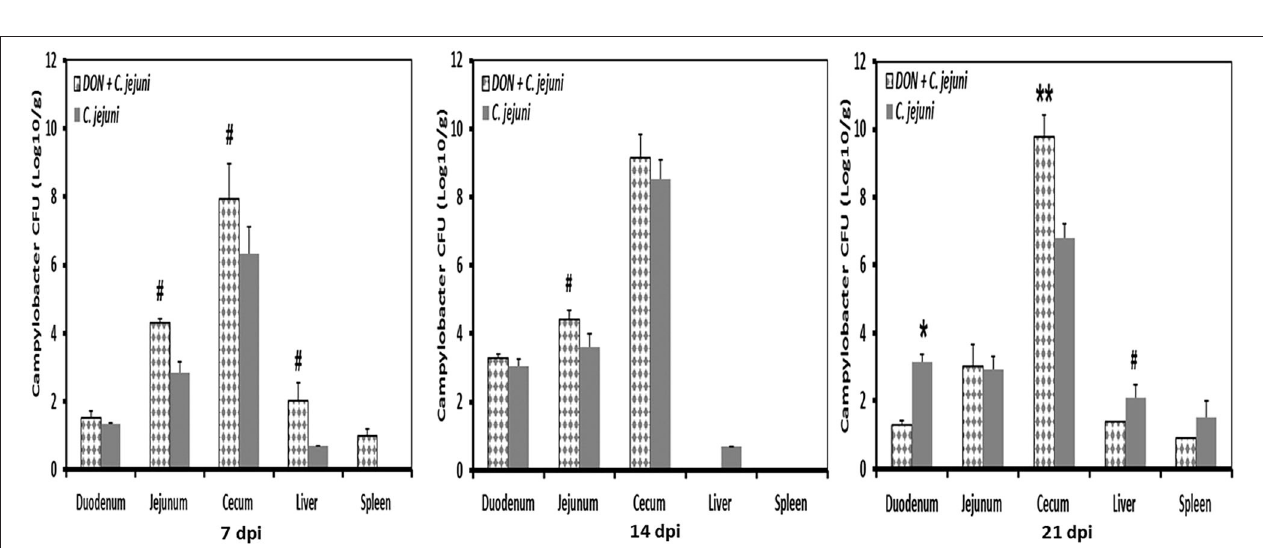
FIGURE 5 | C. jejuni counts at different time points post infection from duodenum, jejunum, cecum, liver, and spleen of infected birds fed with either control or DON contaminated diet. Results are presented as mean values and SEM ( n = 5). Numbers of bacteria are expressed in logarithmic form of colony forming units (log CFU/g). Asterisks mark differences with # P ≤ 0.1, or * P ≤